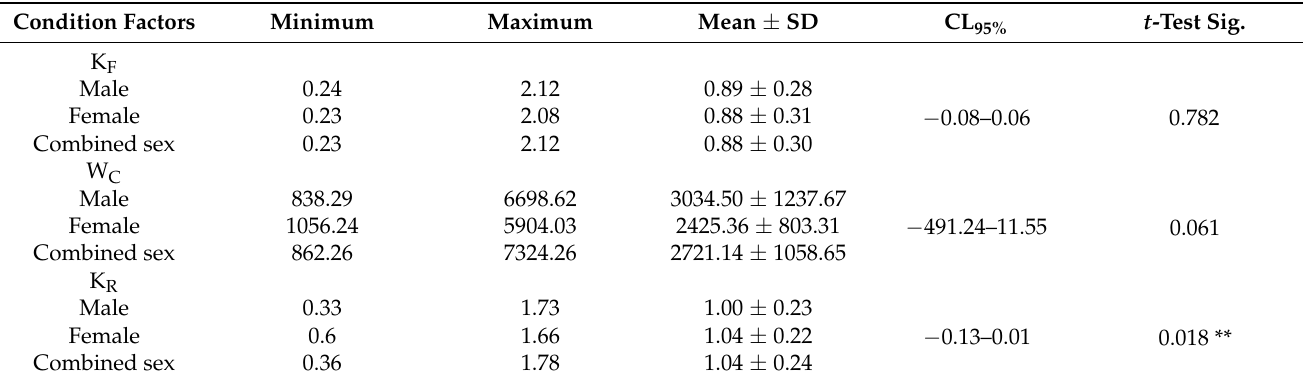
Table 2. Condition factors of Chinese pangolin in different